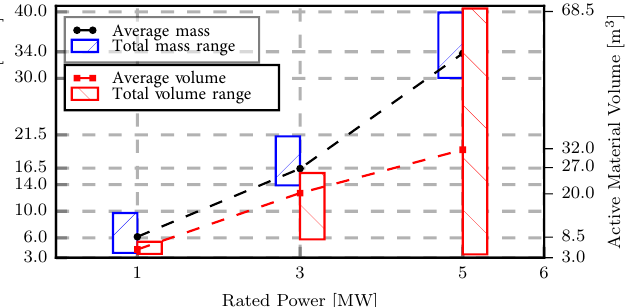
Figure 9. Active mass and volume of PMSM as a function of power rating found in the literature (©[2020] IEEE. Reprinted, with permission from